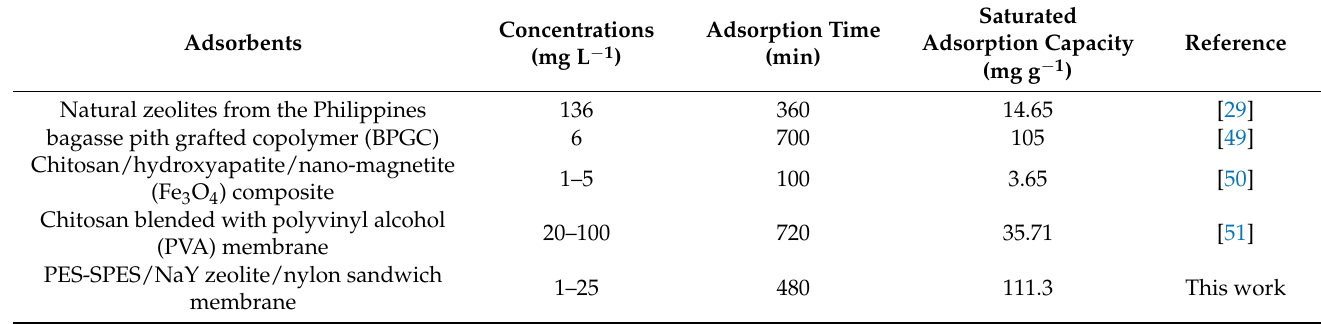
Table 2. Comparison of Cu 2+ adsorption by different adsorbents.